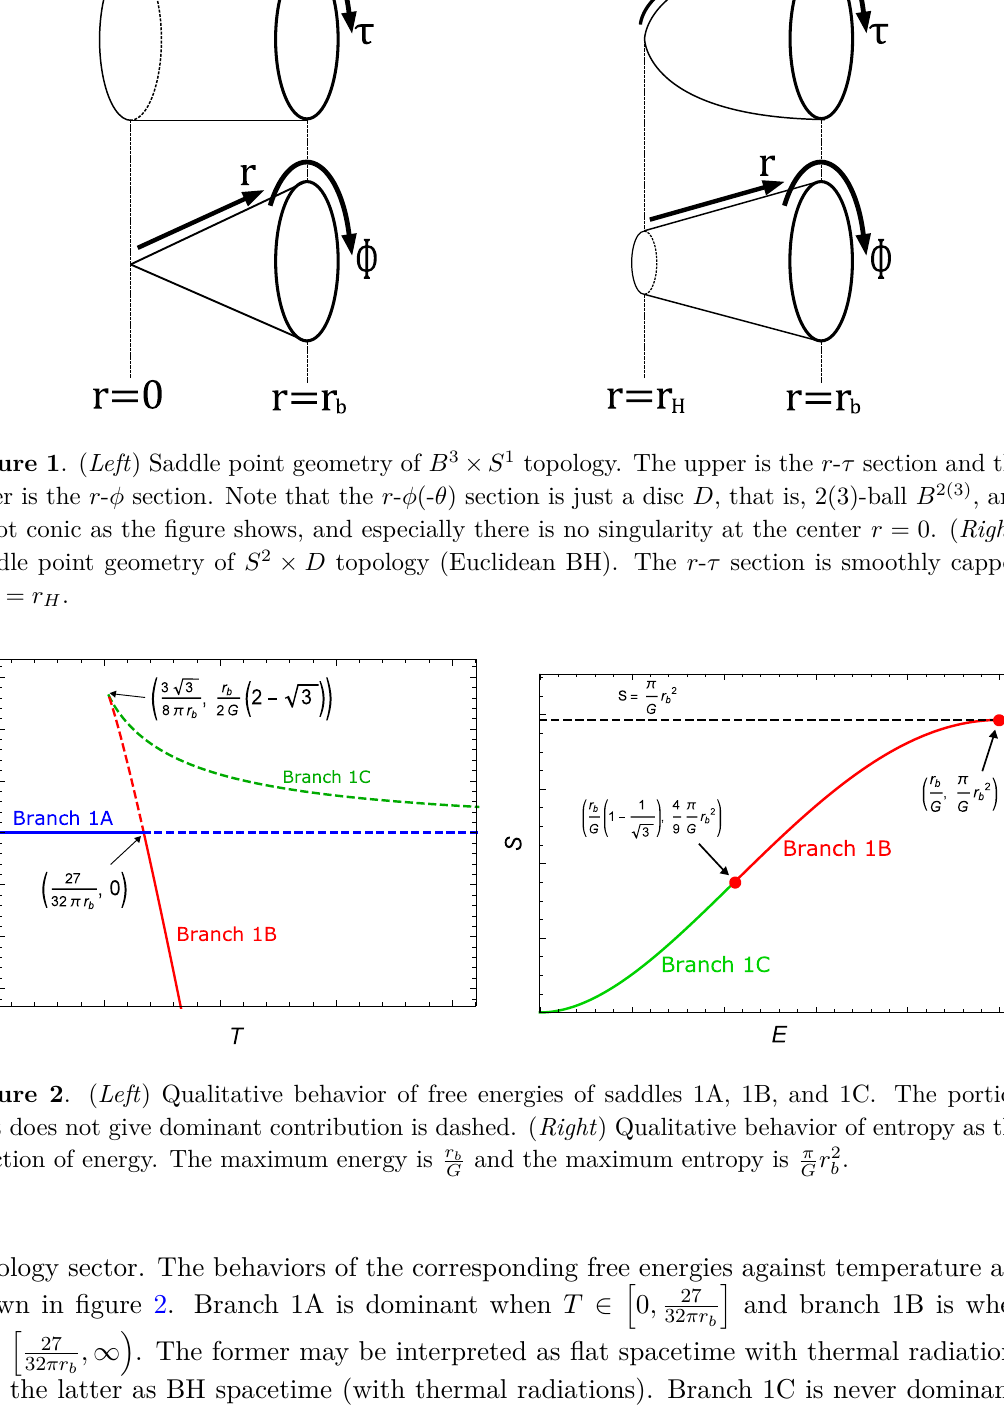
and the maximum entropy is π r 2 b G G